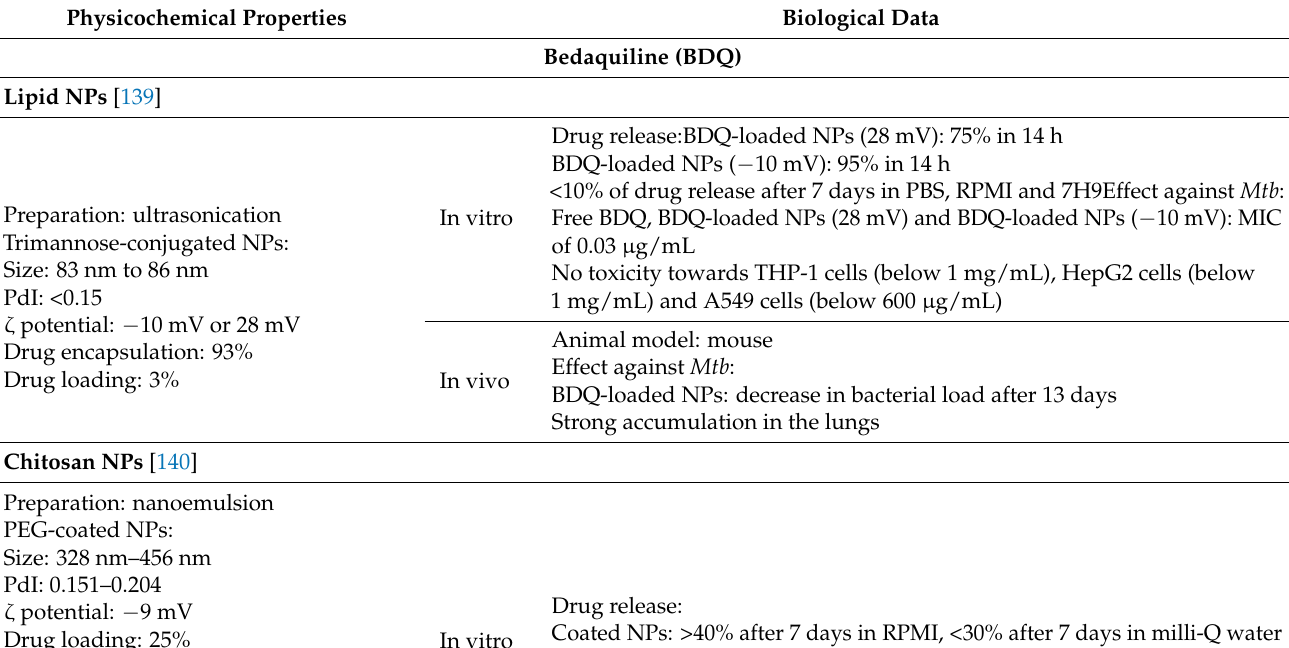
Table 2. Overview of the publications dedicated to the encapsulation of second-line antitubercular drugs, ranked by active molecule and in chronological order. PdI: polydispersity index; drug encapsulation: quantity of encapsulated molecule compared to the quantity of molecule used during the preparation of nanovectors, expressed as a percentage; drug loading: mass of encapsulated molecule compared to the total mass of nanovectors, expressed as a